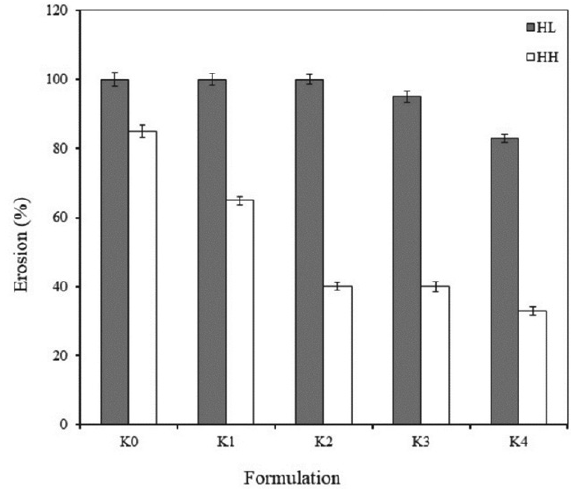
Figure 5. Erosion of film of HPMC K100 LVCR (H L ) and HPMC K100 M (H H ) matrix with varied kaolin content.